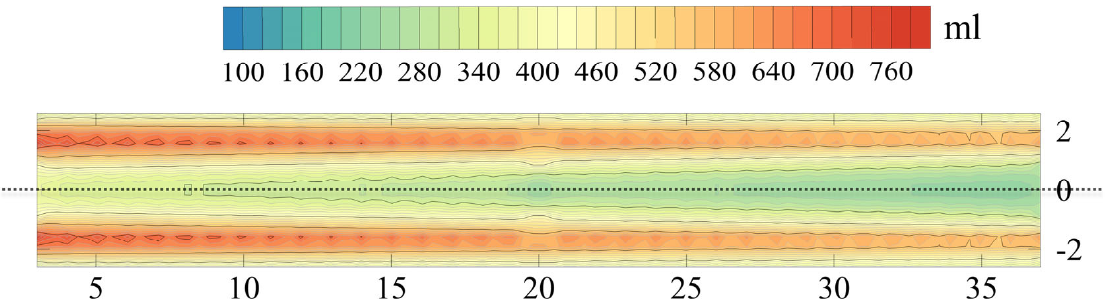
Figure 4. Water distribution of the microsprinkler hose. The figure shows the water distribution. The straight line in the figure is the location of the microsprinkler hose. The abscissa is the longitudinal water distribution (parallel to the direction of the microsprinkler hose), and the ordinate is the transverse water distribution (perpendicular to the direction of the microsprinkler hose).